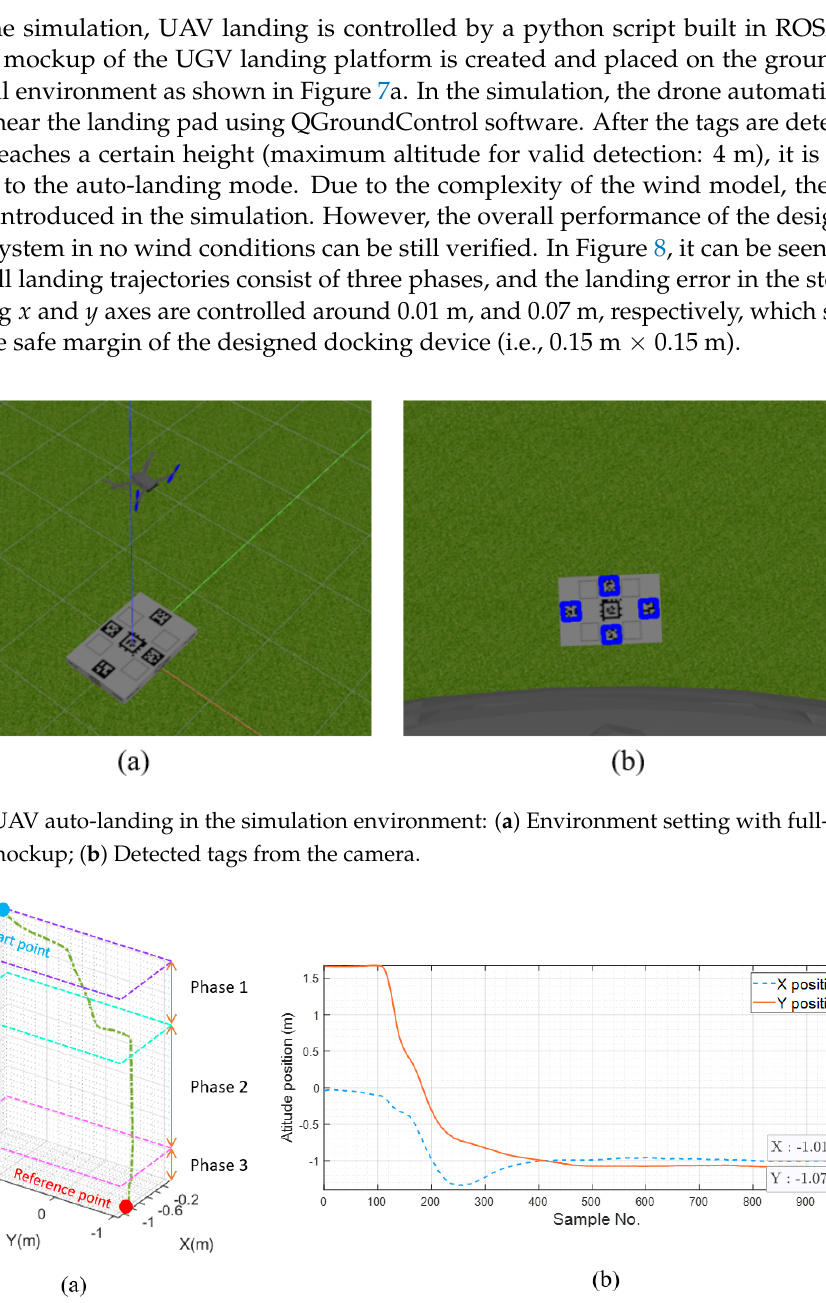
Figure 8. ( a ) Autonomous landing trajectories of the UAV in the simulation; ( b ) Time histories of x , y positions of the UAV with reference point coordinates ( − 1, − 1 )